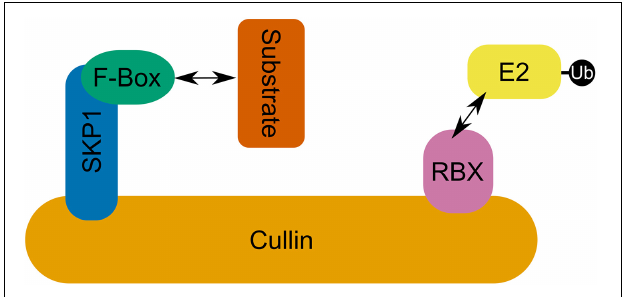
FIGURE 4 | The SCF complex in which an E2 interacting RBX domain containing protein is linked via a Cullin to SKP1 which binds an F-box domain containing protein facilitating SCF complex-substrate interactions.